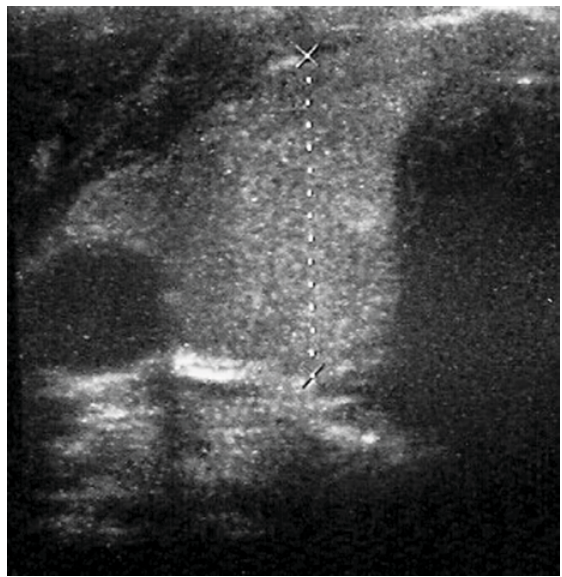
Figure 1. In preoperative term, ultrasonography images of the tumor mass.